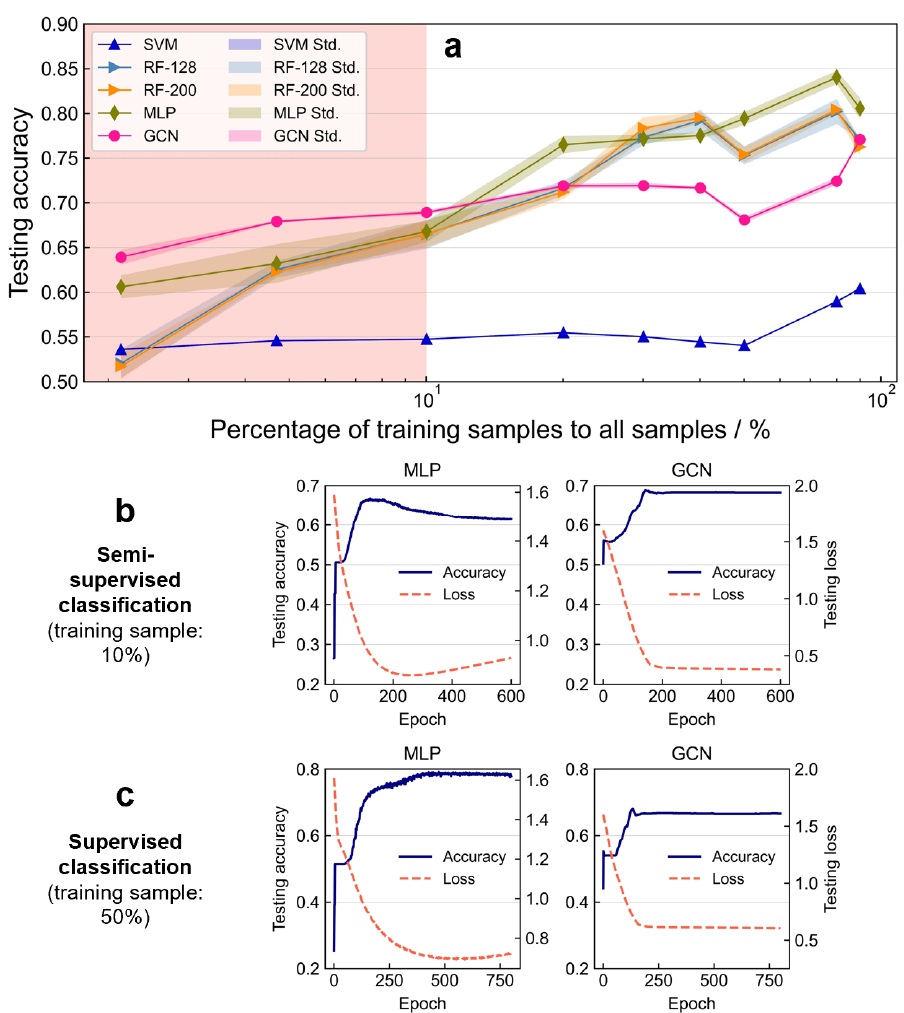
Figure 3. ( a ) Comparing training set size dependence associated with five functional area classifica ‐ tion models: support vector machine (SVM), random forest (RF ‐ 128 and RF ‐ 200), multi ‐ layer per ‐ ceptron (MLP) and graph convolutional network (GCN), indicating a best performance with GCN under semi ‐ supervised situation and a best performance with MLP under supervised situation; ( b